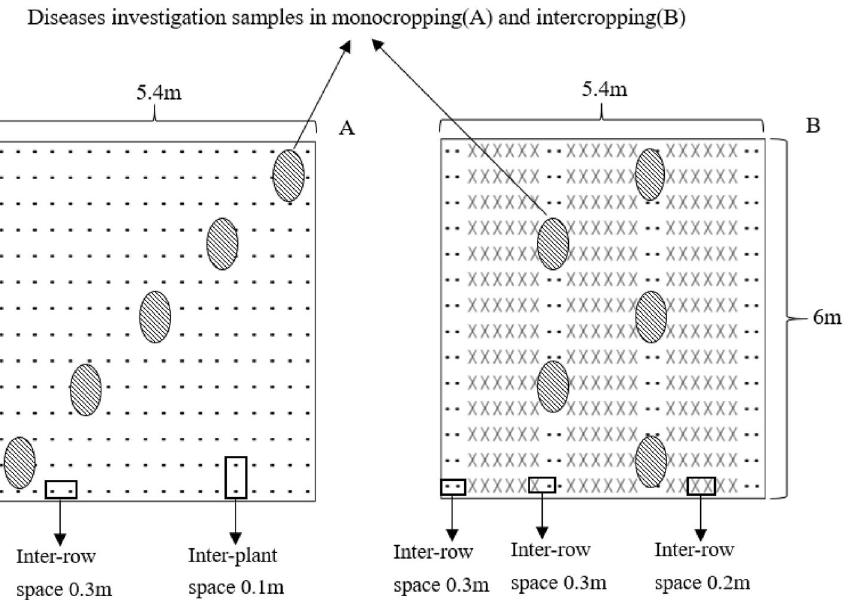
Figure 5. Diagram of the planting patterns in the field experiments: ( A ) the monocropping faba bean plot, ( B ) the intercropping faba bean with wheat plot (− represents faba bean and × represents